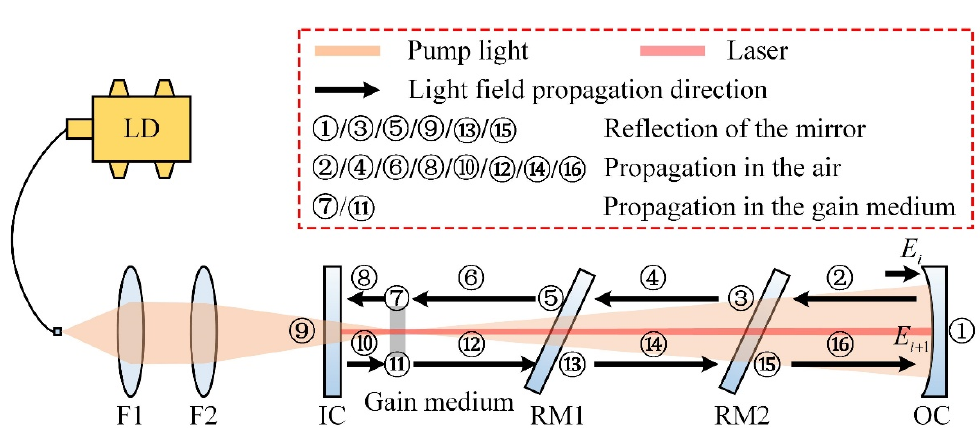
Photonics 2022 , 9 , x FOR PEER REVIEW 3 of 12 Figure 4. Schematic of the intra-cavity propagation iteration of the light field. 2.2.3. Vortex Beam Generation and Identification